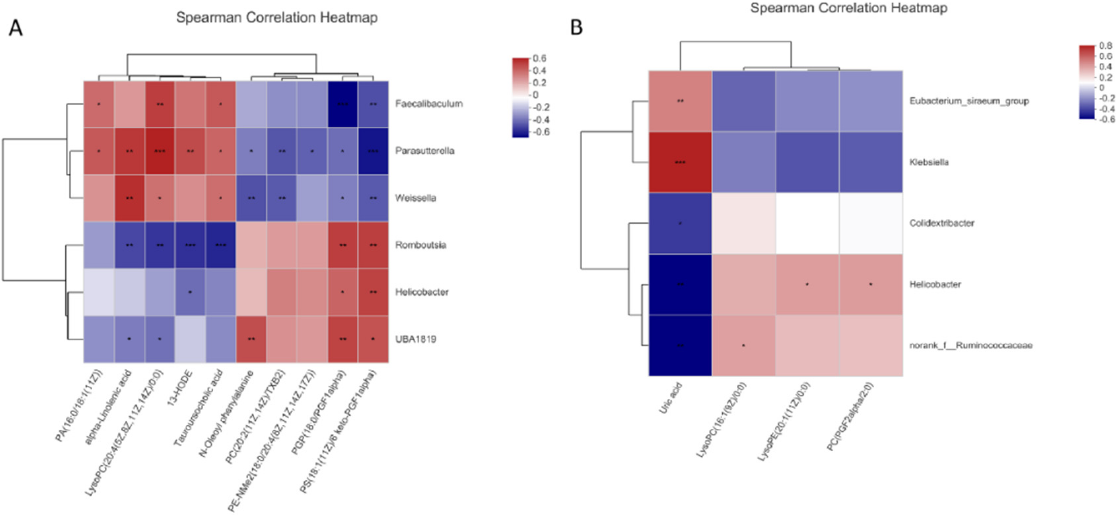
Figure 19. Correlation analysis between the cecal microflora and metabolites affected by Pueraria polysaccharide intervention (( A ): GG; ( B ): FG; red represents a positive correlation, blue represents a negative correlation, * p < 0.05, ** p < 0.01, *** p < 0.001).